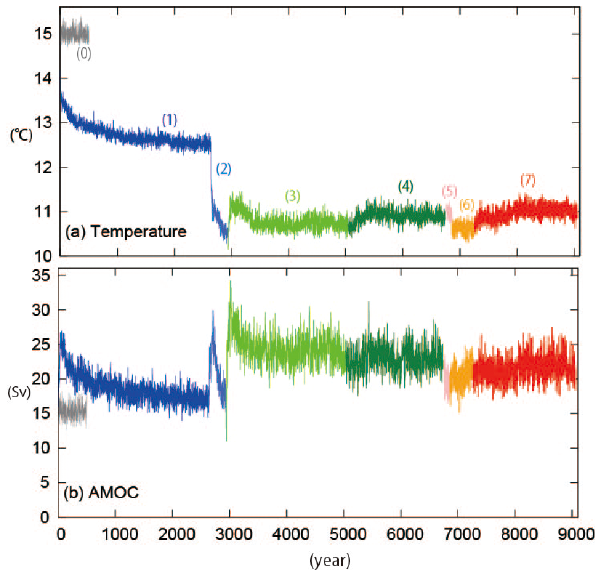
Figure 5. Time series for spin-up and submitted period (final 100 years) of LGM experiment and PI as a reference for (a) global mean air temperature at 2m height and (b) peak values of annual mean AMOC. Gray line (0) denotes PI value. Blue line (1): the ex- periment with only GHG levels set to LGM values. Light blue line (2): with the land–sea distribution and land PFTs changed to the LGM states. Light green line (3): with altitude set to the LGM state. Dark green line (4): with orbit of the Earth set to the LGM value. Pink line (5): spin-up experiment using MIROC-ES2L after VISIT- e offline spin-up. Orange line (6): with erodibility map and offset of ocean salinity applied. Red line (7): final spin-up after offline spin-up experiments by VISIT-e and OECO2.